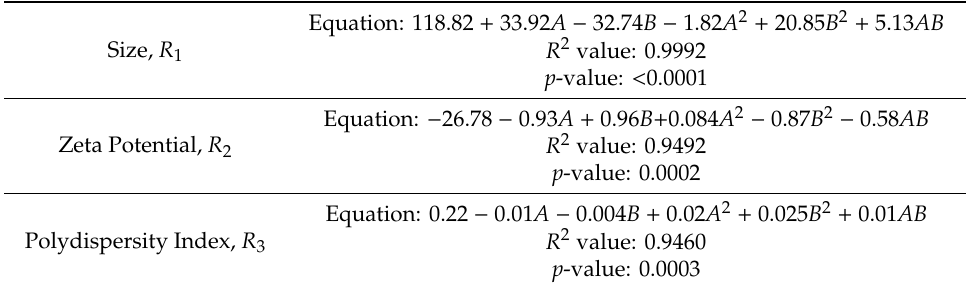
Table 2. Equations, regression coe ffi cients and probability values for reduced model of